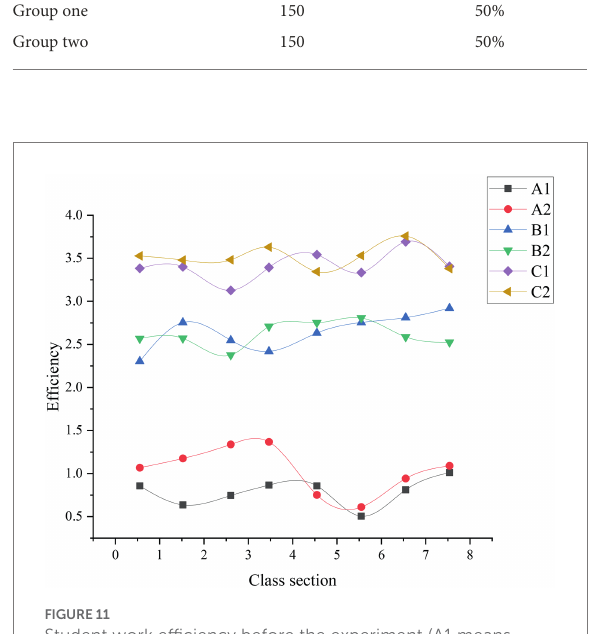
FIGURE 11 Student work efficiency before the experiment (A1 means ordinary student in Group 1, A2 means ordinary student in Group 2, B1 above-average student in Group 1, B2 means above-average student in Group 2, C1 means extraordinary student in Group 1, C2 means extraordinary student in Group 2).